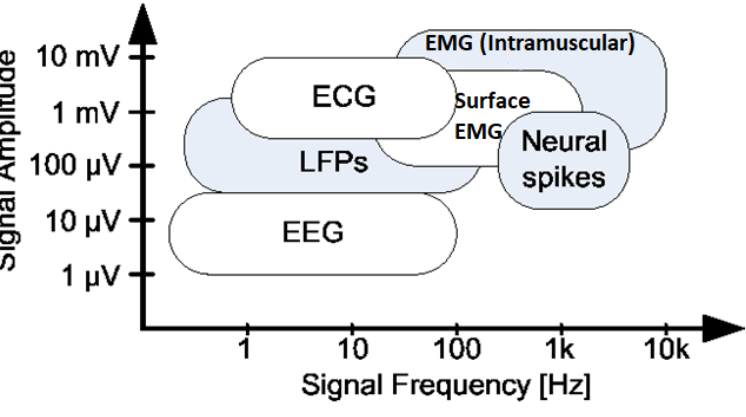
Figure 1. Biopotential signals signal level and bandwidth.